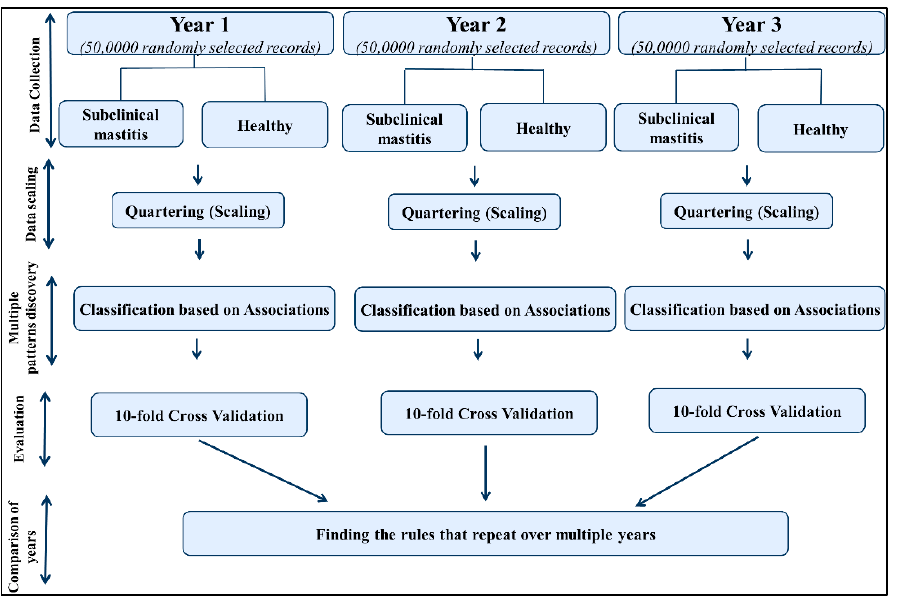
Figure 1. Schematic representation of the rule discovery pipeline for subclinical mastitis prediction from milking features over multiple years by combination of data scaling (quartiling) and classification based on associations model.